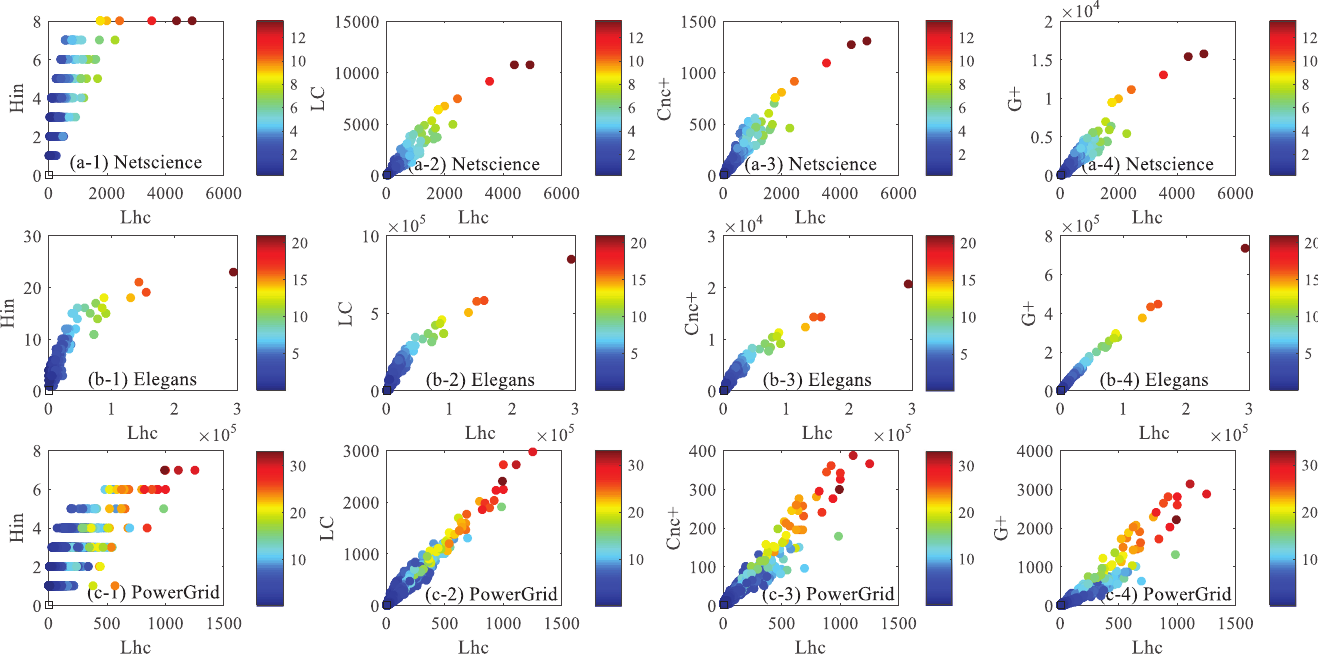
Fig 6. Spreading abilities comparison between Lhc and other four centralities (Hin, LC, Cnc + , G + ). (a)-(c):The comparison corresponds to the network of Netscience, Elegans and PowerGrid respectively. Each point denotes a node, the x axis denotes the nodes’ Lhc value, and the y axis denotes the value of one of the other four centrality measures. The color represents the spreading influence of this node, namely